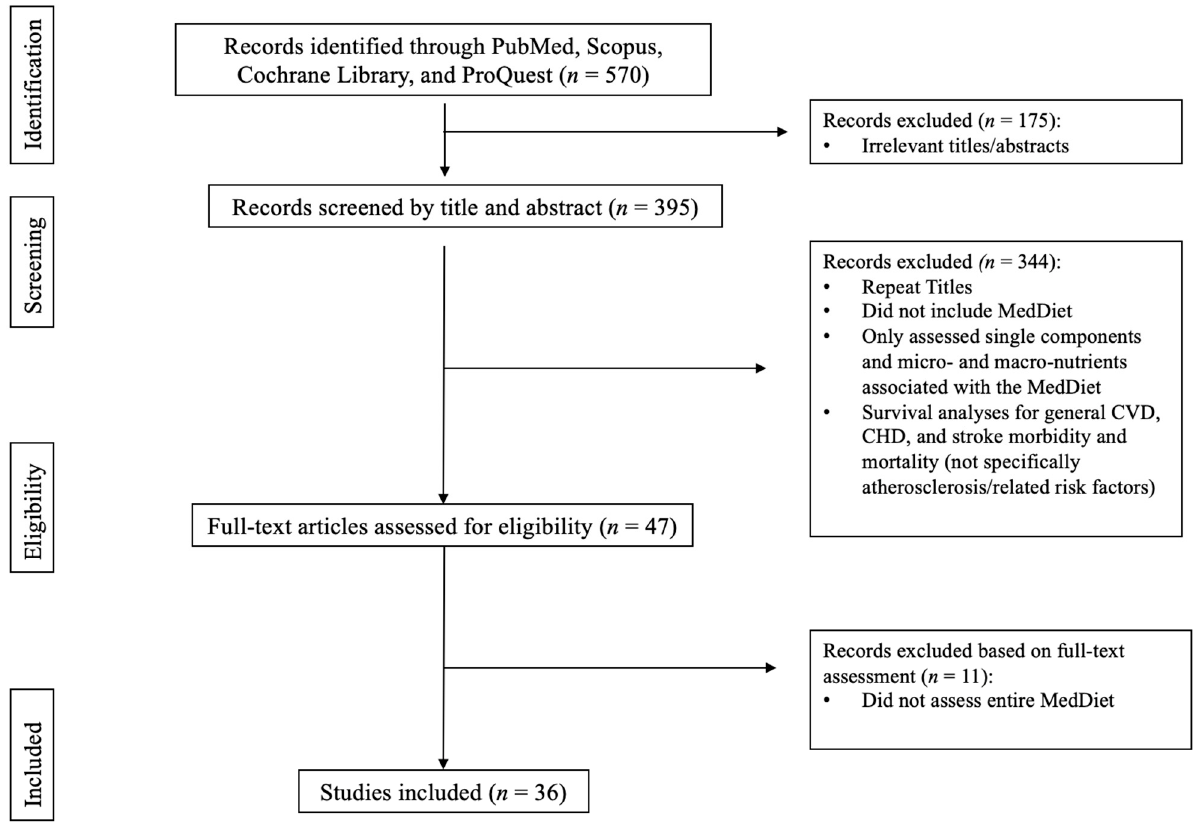
Figure 1. Article